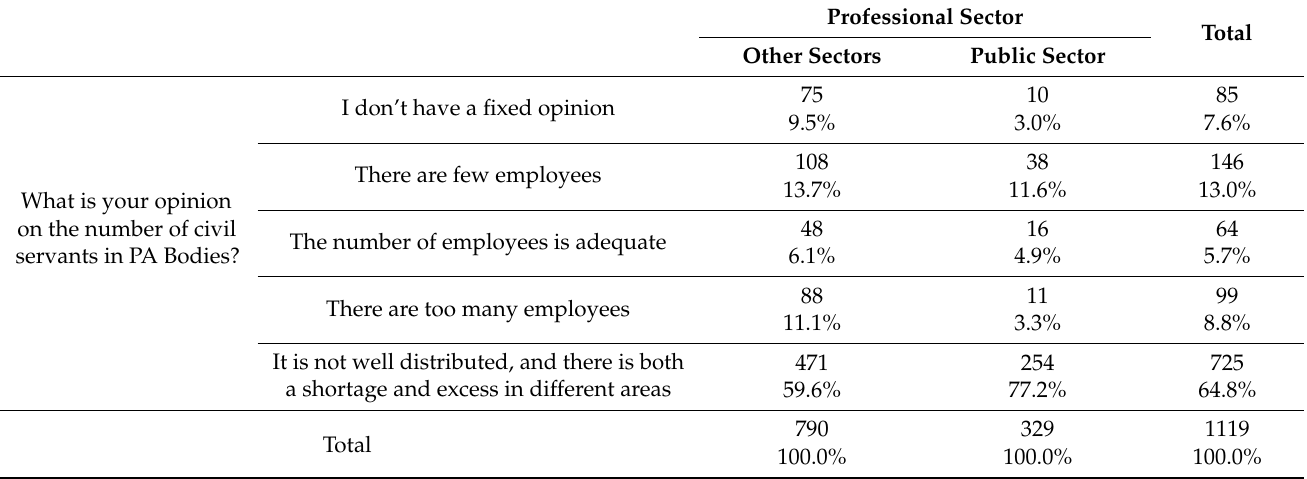
Table 5. What is your opinion on the number of civil servants in PA Bodies? Professional Sector